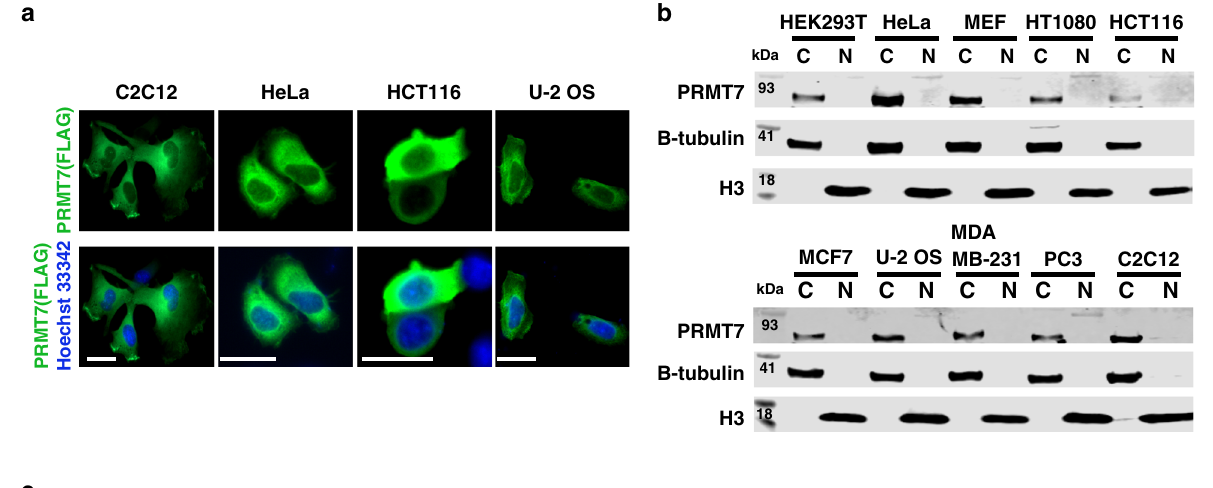
signi fi cant change in protein abundance for the differentially methylated peptides indicating that the observed reduction in methylation was due to reduced monomethlation activity as opposed to perturbation of total protein levels (Supplementary Table 4). Most of the identi fi ed methylated proteins were